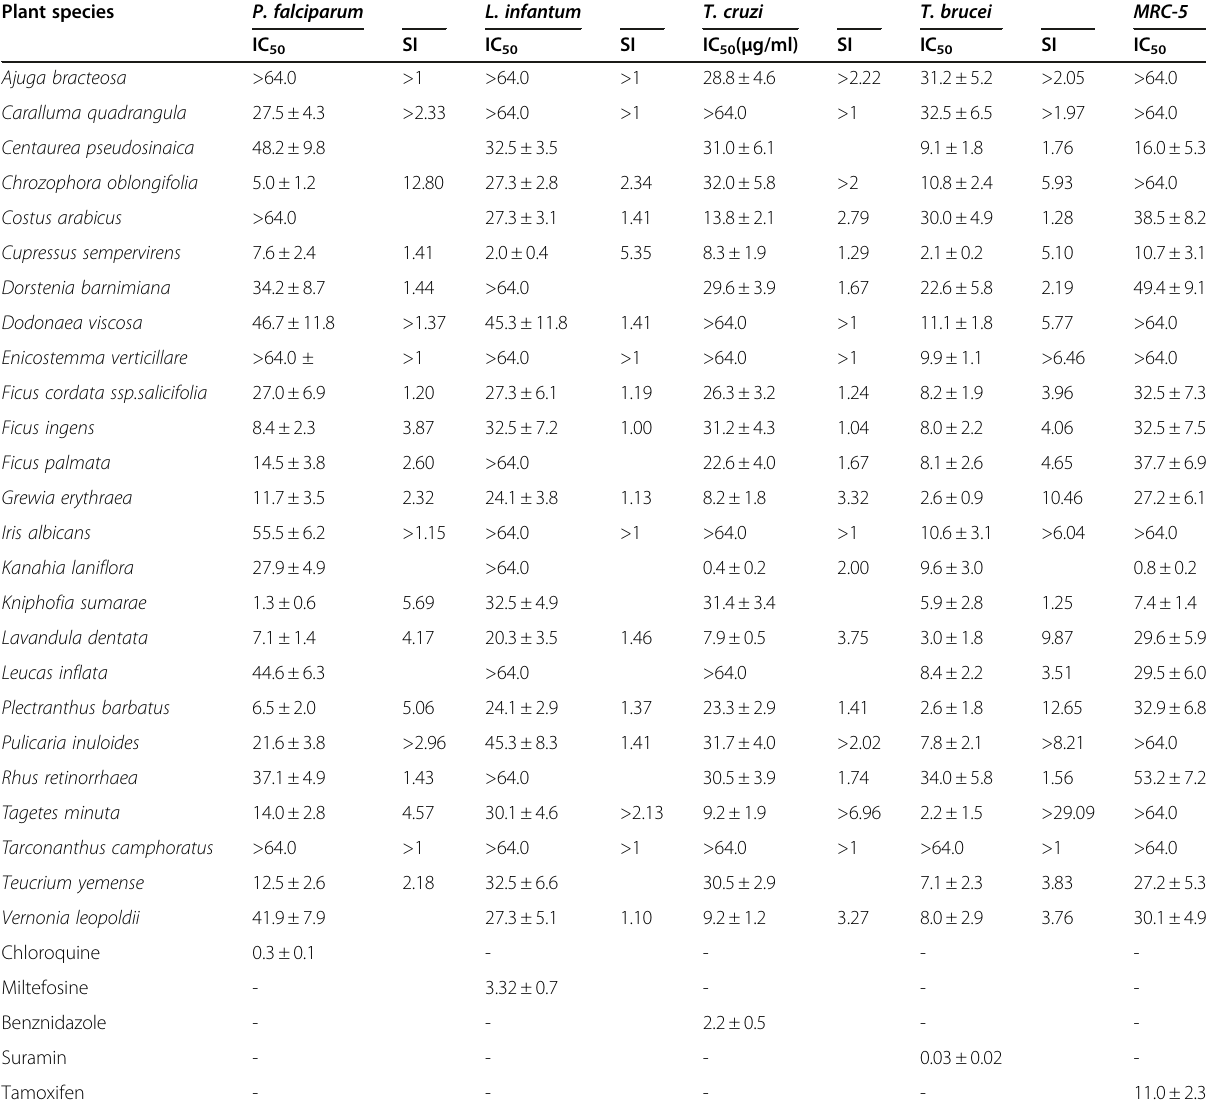
Table 2 Antiprotozoal activity of the methanol extracts of the investigated plants and their cytotoxicity against MRC-5 cell